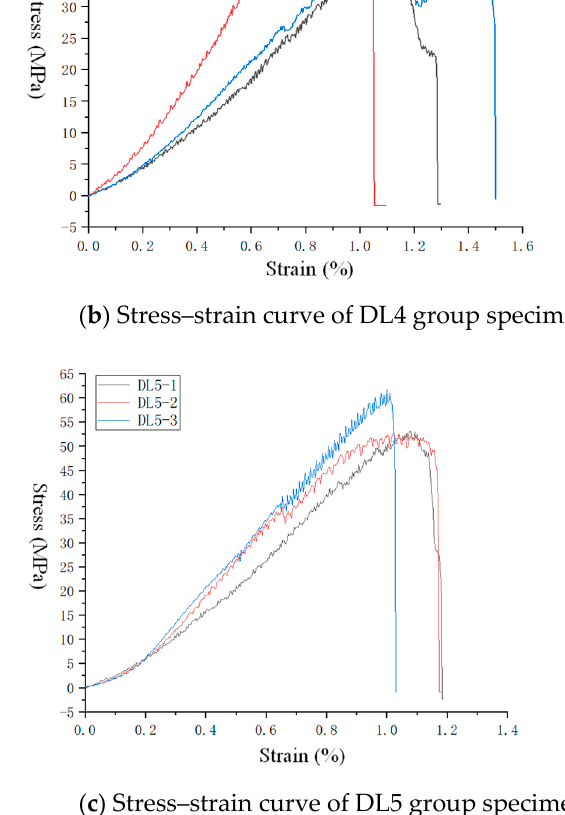
Figure 3. Stress–strain curves of marble specimens.